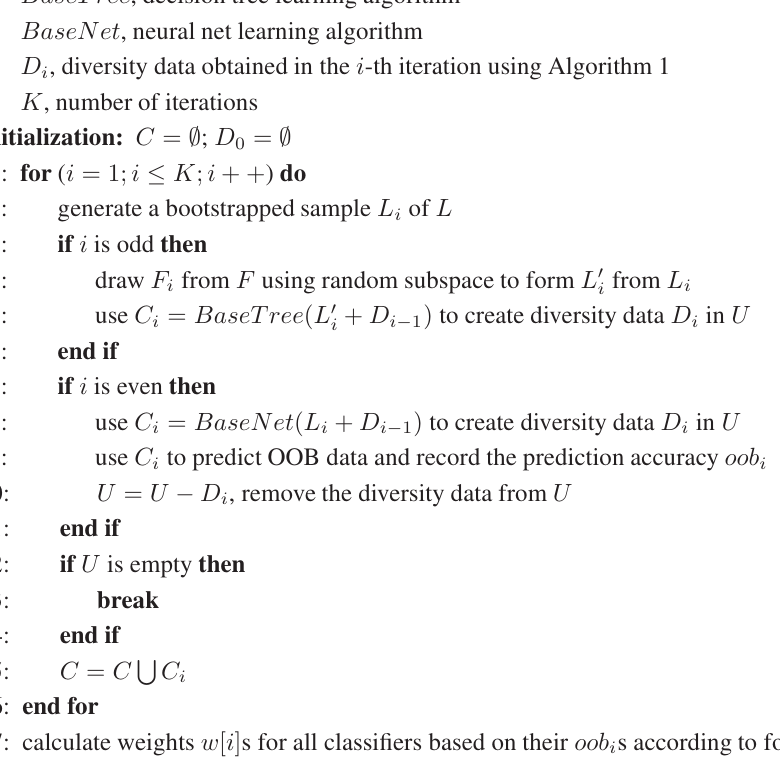
BaseT ree , decision tree learning algorithm BaseNet , neural net learning